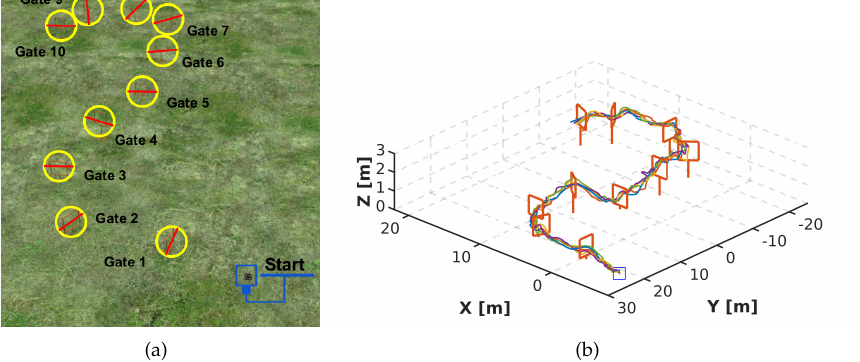
Figure 22. Second racetrack to evaluate DeepPilot using a mosaic of 6 frames. The track spans over a surface of 50 m × 23 m, and the space in between gates goes from 5 m to 9 m. Note that this track was not used for training. ( a ) The track is formed by 10 gates: 4 gates of 1.2 m height and 6 gates of 2 m height. ( b ) Drone’s trajectories obtained for 5 runs for this racetrack. DeepPilot piloted the drone in the track providing the flight commands ( φ , θ , ψ , h ) . A video illustrating the performance of our proposed DeepPilot in this racetrack can be found at https://youtu.be/Qo48pRCxM40